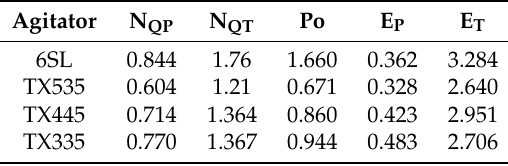
Table 2. The pumping and circulation efficiency of axial flow agitators in the turbulent flow region—flat bottomed cylindrical vessel and four radial baffles, H / D = 1, D / d = 3, H 2 / d = 1 [13].